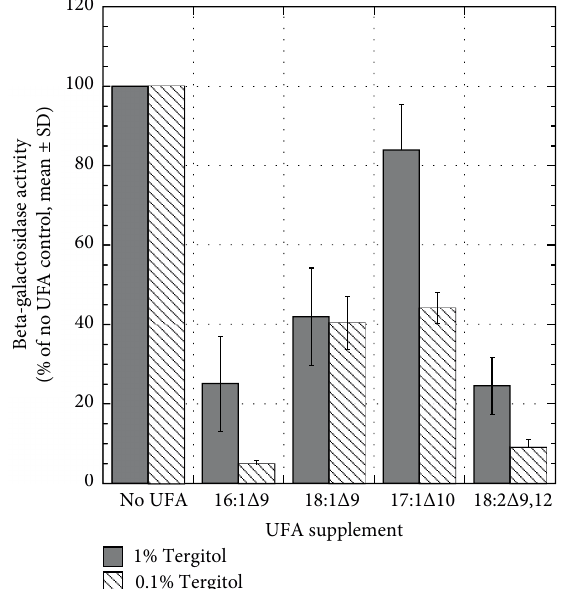
Figure 2: Effect of UFA species and tergitol concentration growth conditions on OLE1 expression. Wild type strain W303-1A with plasmid p62 ( OLE1 promoter- lacZ reporter) was grown overnight, and refreshed into YNBt medium with either 1% tergitol or 0.1% tergitol, containing 1 mM noted fatty acid, or 1% ethanol for control, for four hours. Cells were harvested and β -galactosidase activity determined. Activity was normalized to ethanol control. At least 5 replicates were performed for each growth condition.